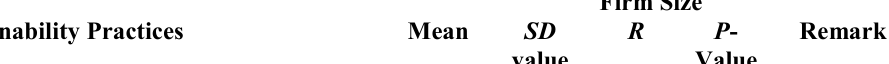
Table 4. Influence of Construction Firm Size on the Adoption of Sustainability Practices (developed by the